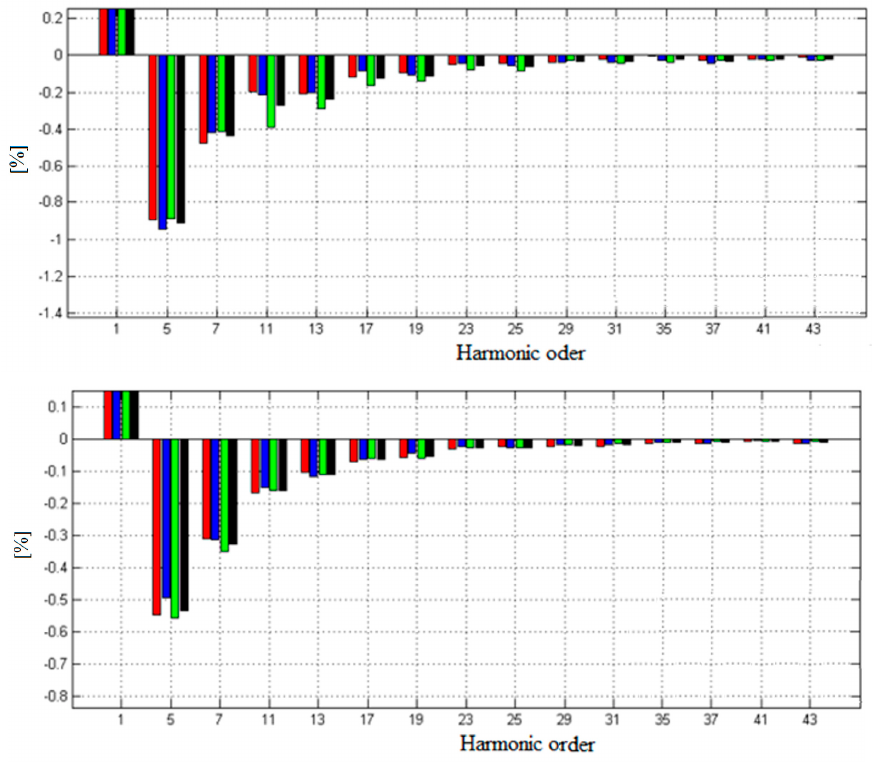
Figure 4. Harmonic spectra of the absorbed currents ( top ) and input voltages ( bottom ) were acquired from the secondary winding of the transformer for the excitation supply (harmonic weights > 1.2%). The (re)active powers were computed by using the harmonic spectra and Equations (9), (12) and (21). Their spectra are depicted in Figure 5.